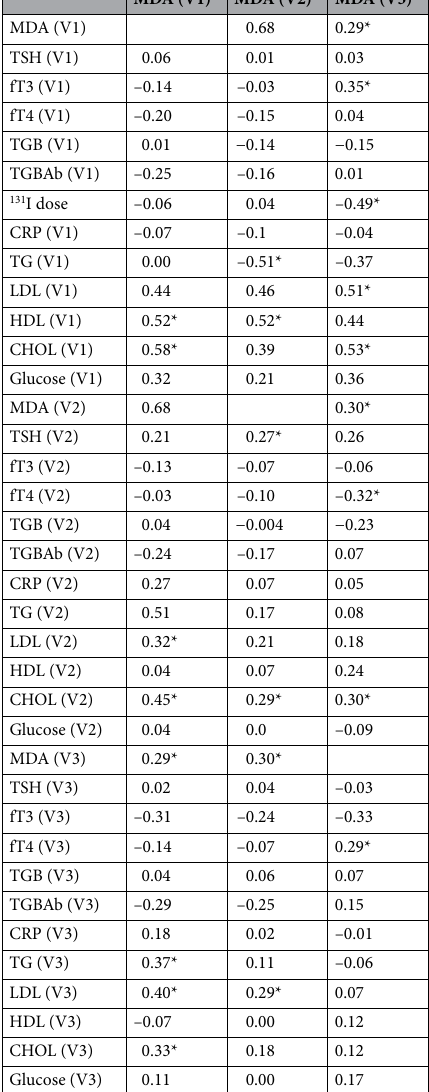
Table 2. Spearman’s correlation of the MDA concentrations and the other measurements at visit 1 (baseline), visit 2 (3 days after the RAI treatment), and visit 3 (1 year after the RAI treatment). 131 I radioiodine, TGBAb thyroglobulin antibodies, CHOL cholesterol, CRP human C-reactive protein, fT3 free triiodothyronine, fT4 free thyroxine, HDL high-density lipoprotein, LDL low-density lipoprotein, MDA malondialdehyde, TG triglyceride, TSH thyroid-stimulating hormone. * p <